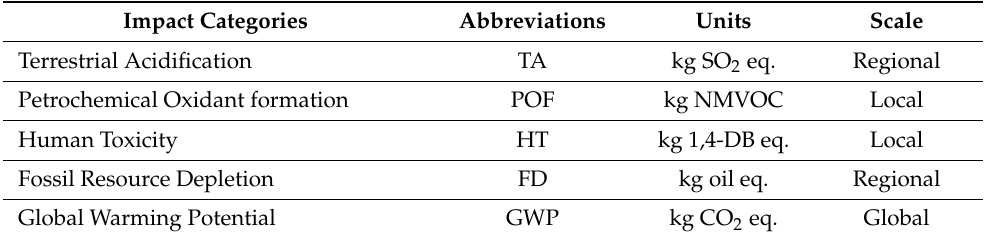
Table 1. An overview of the mid-point impact categories selected from the Recipe handbook 2008 [33].